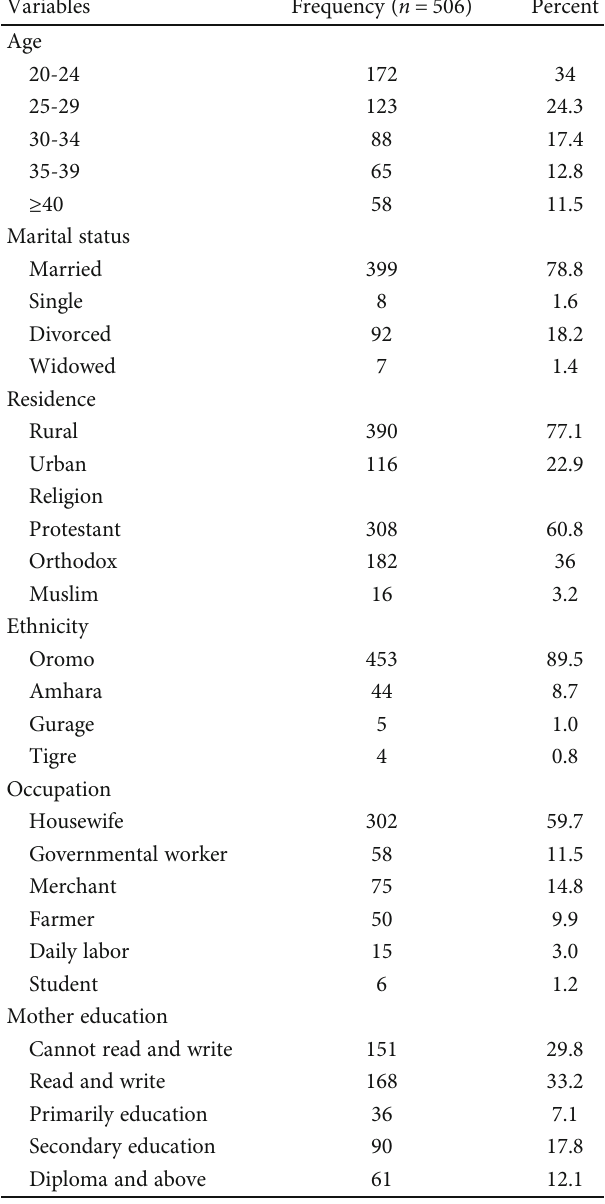
Table 1: Sociodemographic characteristics of respondents in Jimma Arjo District, Oromia, Ethiopia,